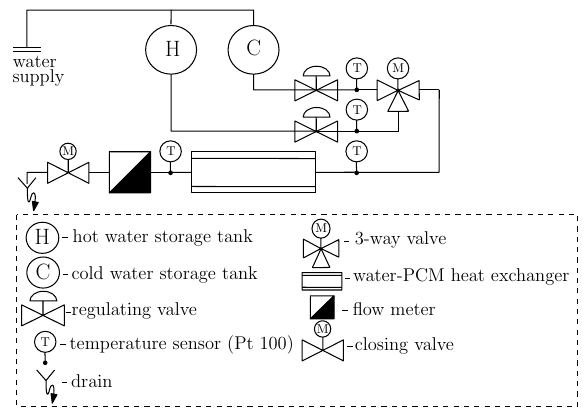
Fig. 2. Schematics of the experimental setup